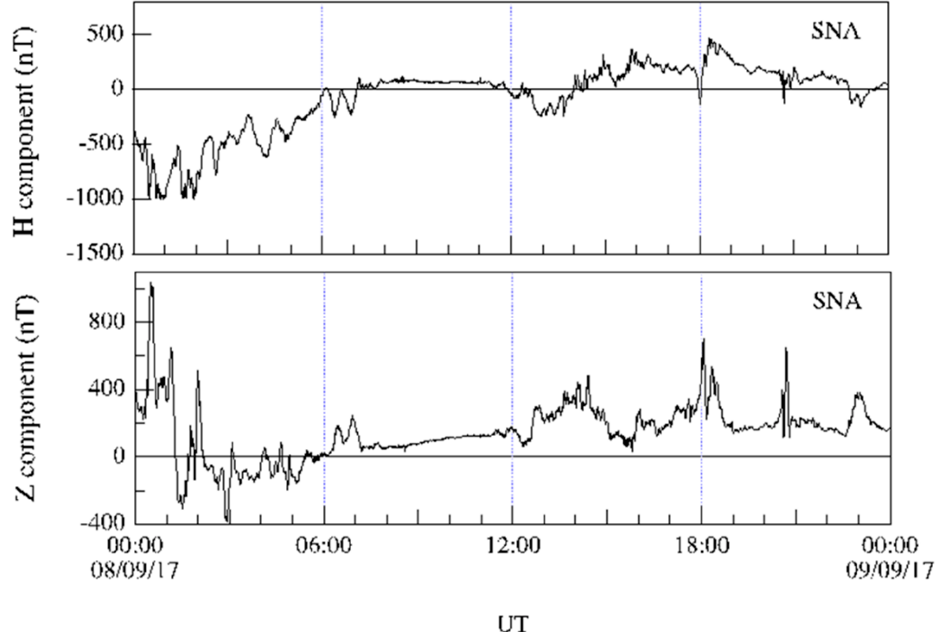
Figure 6. H and Z magnetic field components recorded at SNA magnetic station located in